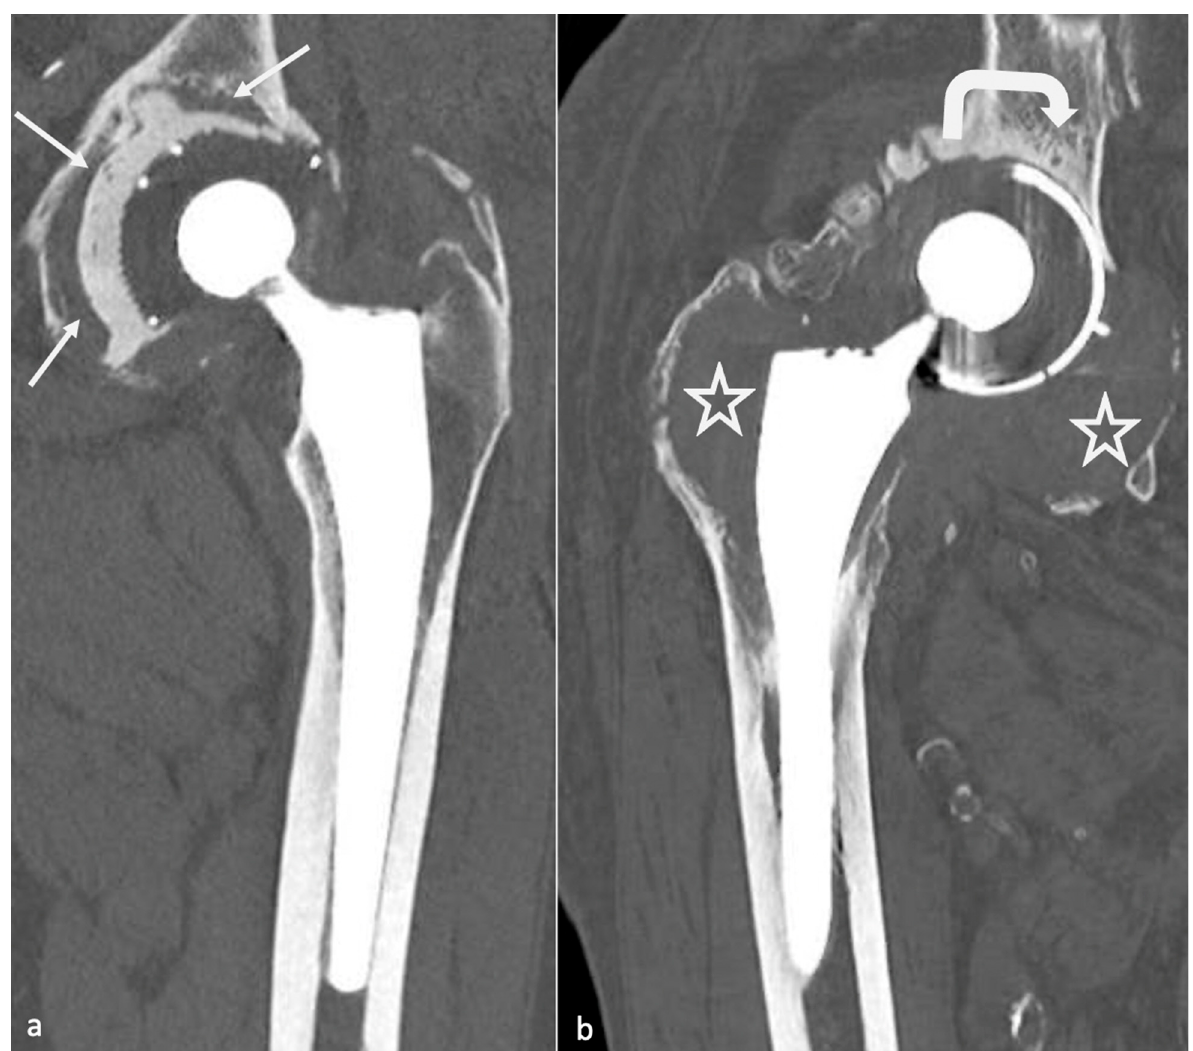
Figure 17. Mechanical and granulomatous loosening. An acetabular mechanical loosening is shown on ( a ) a frontal CT-scan slice with regular acetabular osteolysis (white arrows). A granulomatous loosening is shown on ( b ) a frontal CT-scan slice and consists of bulky osteolysis (white stars) both on the femoral and acetabular sides, with a displacement of the acetabular metal-back (white curved arrow).